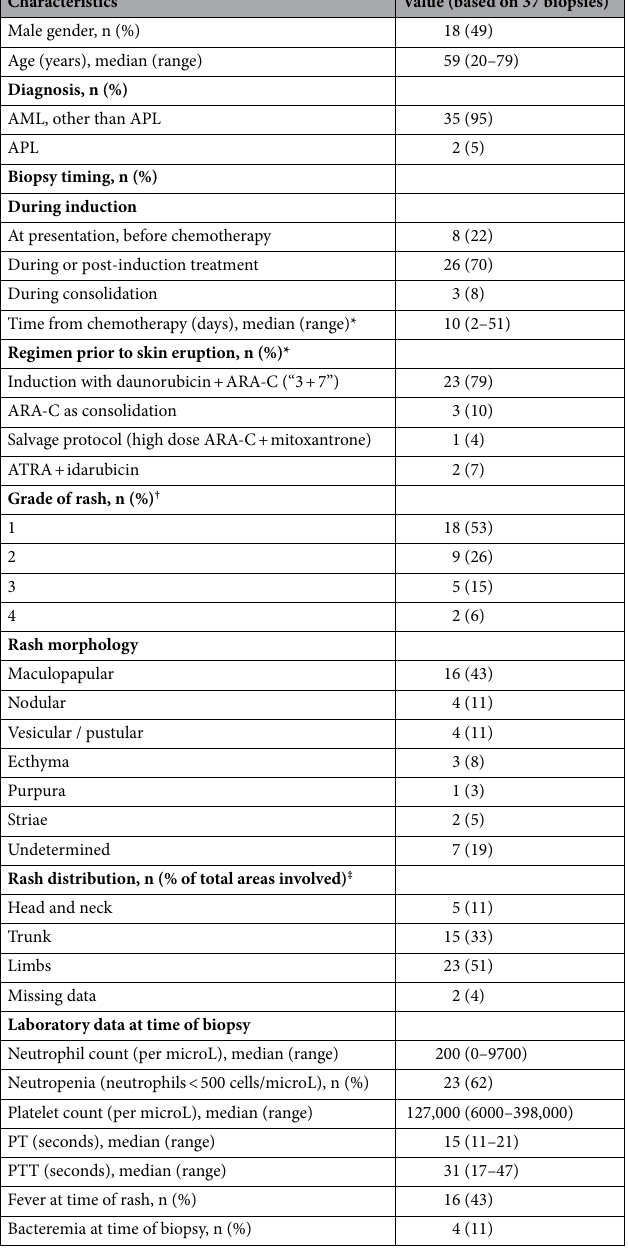
Table 1. Characteristics of 35 patients undergoing 37 skin biopsies during hospitalization for intensive chemotherapy for AML. *For the 29 skin eruptions appearing after chemotherapy commencement. † Data available for 34/37 skin biopsies. Grade according to CTCAE, version 5 12 . ‡ If rash involved more than one body part, it was counted more than once. Value represents percent of total areas involved in all patients (n = 45). AML acute myeloid leukemia, APL acute promyelocytic leukemia, 3 + 7 daunorubicin and cytarabine, ARA-C cytosine arabinoside, ATRA all trans retinoic acid, CTCAE Common Terminology Criteria for Adverse Events, PT prothrombin time, PTT partial thromboplastin